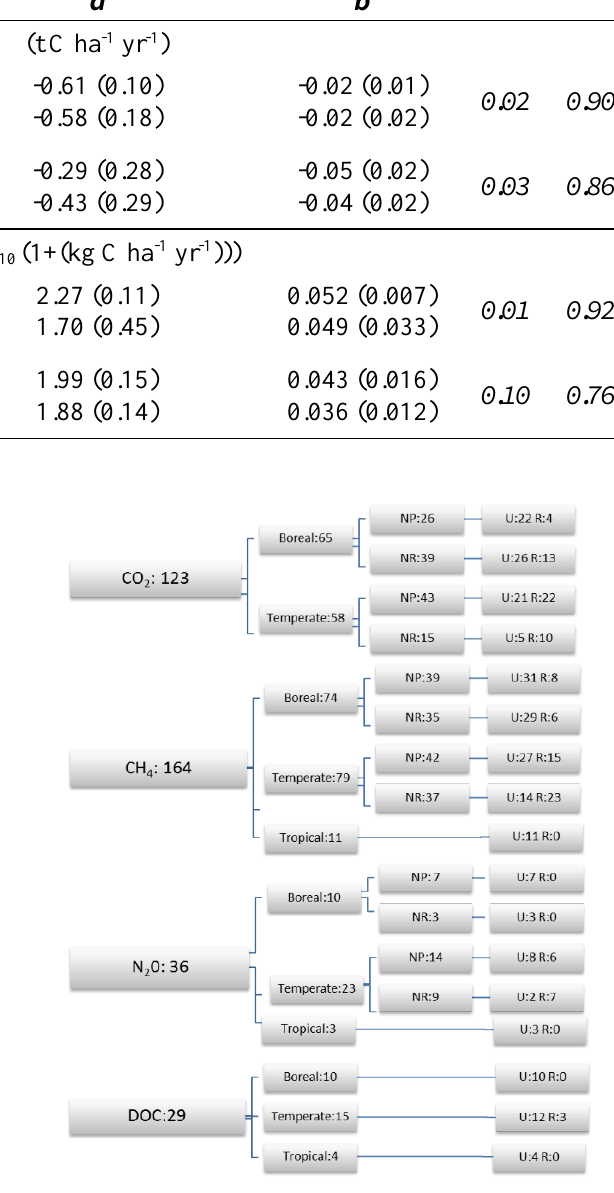
Figure 3. Number of data entries (see main text for inclusion criteria) used to derive carbon dioxide (CO 2 ), methane (CH 4 ), nitrous oxide (N 2 O) and dissolved organic carbon (DOC) emission factors. Entries are disaggregated by climate zone (boreal, temperate and tropical), nutrient status (NP = nutrient poor, NR = nutrient rich) and drainage status (U = undrained, R =